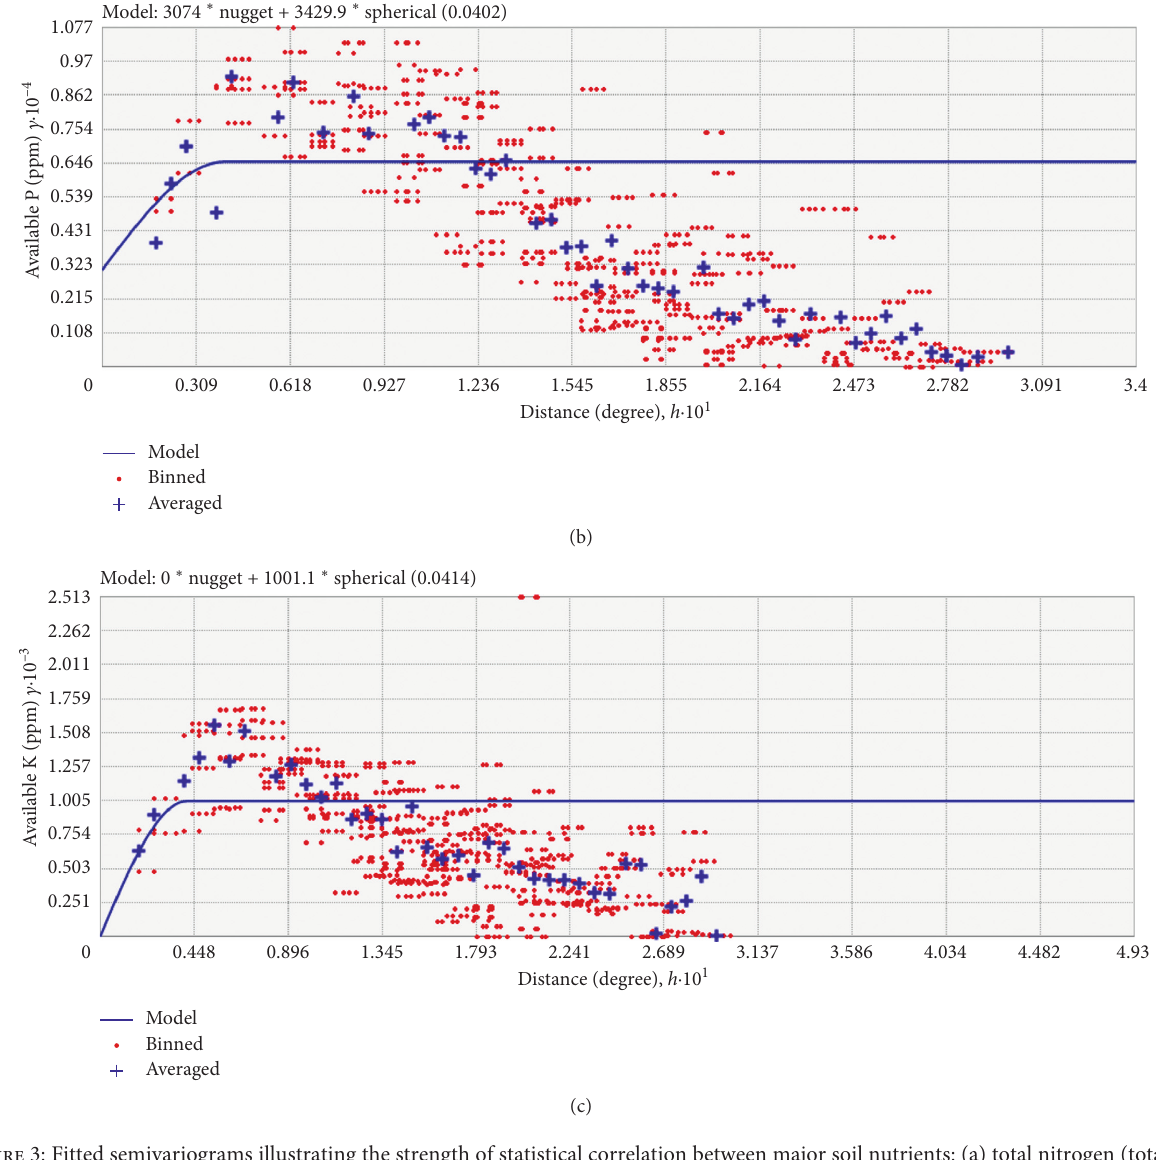
Figure 3: Fitted semivariograms illustrating the strength of statistical correlation between major soil nutrients: (a) total nitrogen (total N), (b) available phosphorus (Av P), and (c) available potassium (Av K) in the study